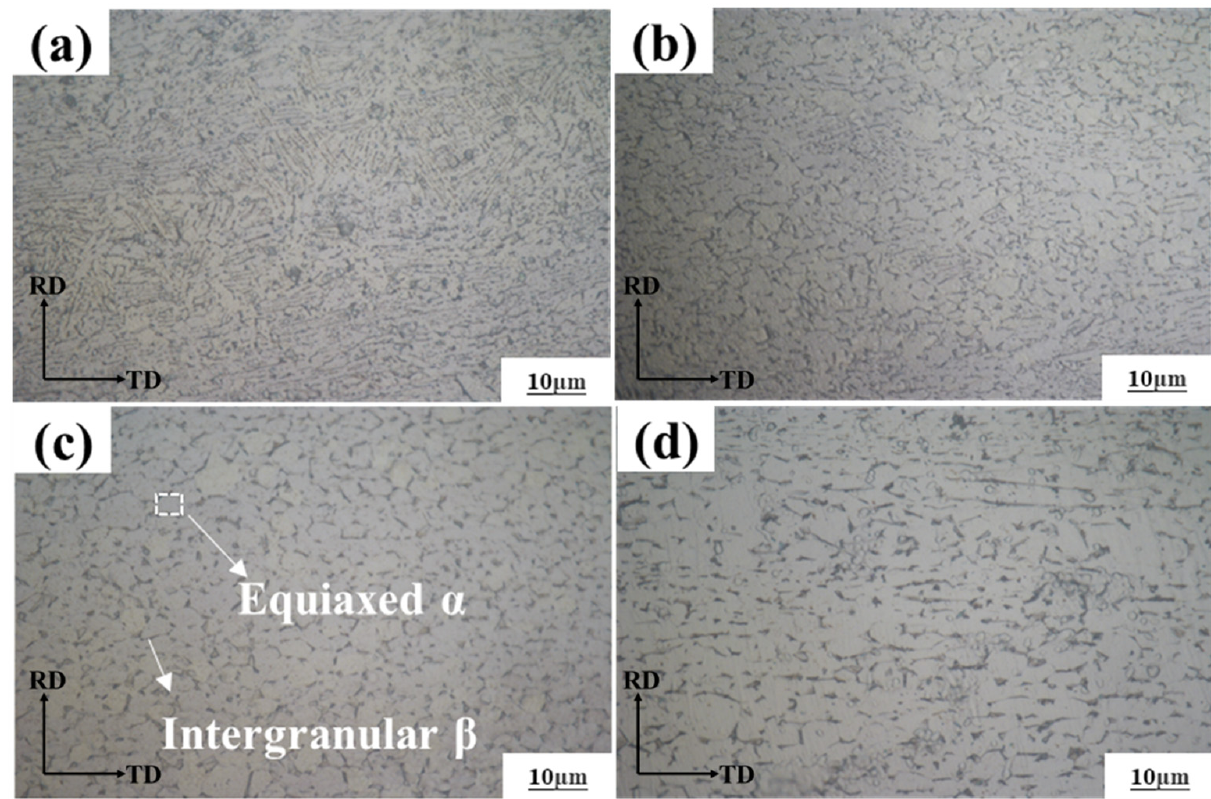
Figure 3. OM images of annealed TA10 alloy at different times ( a ) 0.5 h, ( b ) 1 h, ( c ) 2 h, and ( d ) 4 h.